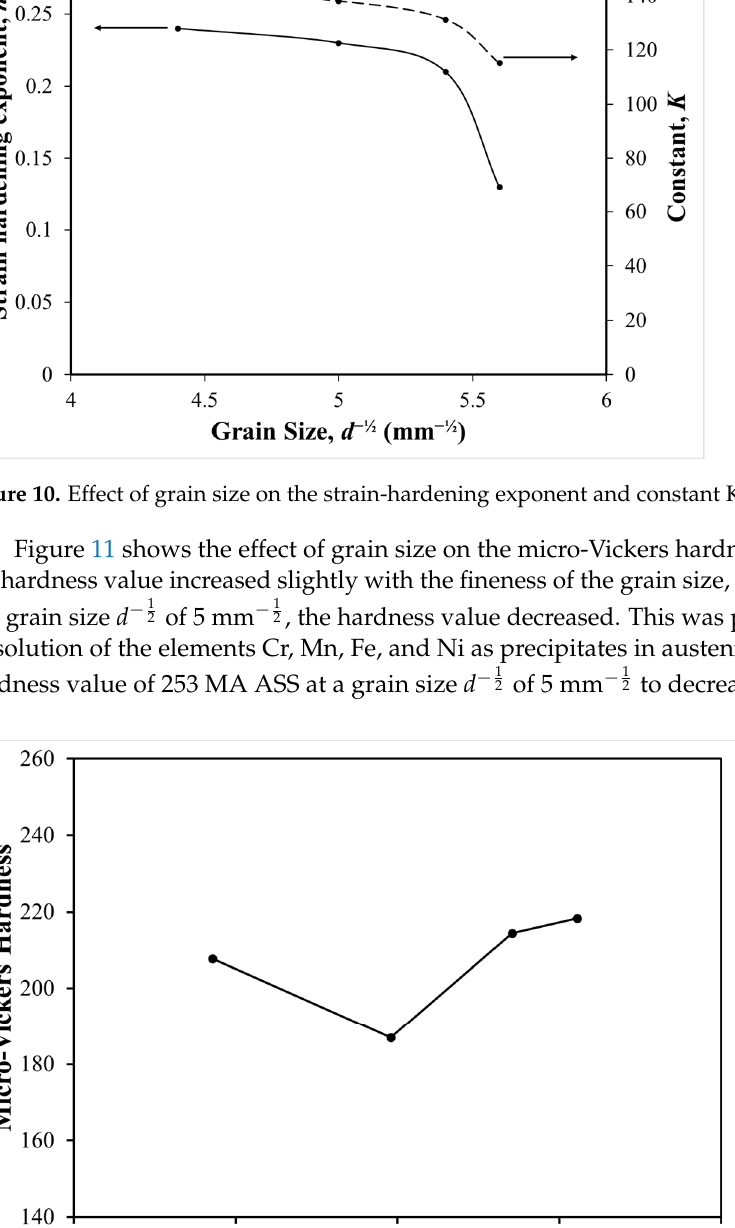
Figure 12. SEM observations of the tensile test fractures of 253 MA ASS after ( a ) cold rolling and ( b ) annealing at 1100 °C with annealing times of ( c ) 900; ( d ) 1800; ( e ) 3600 s.